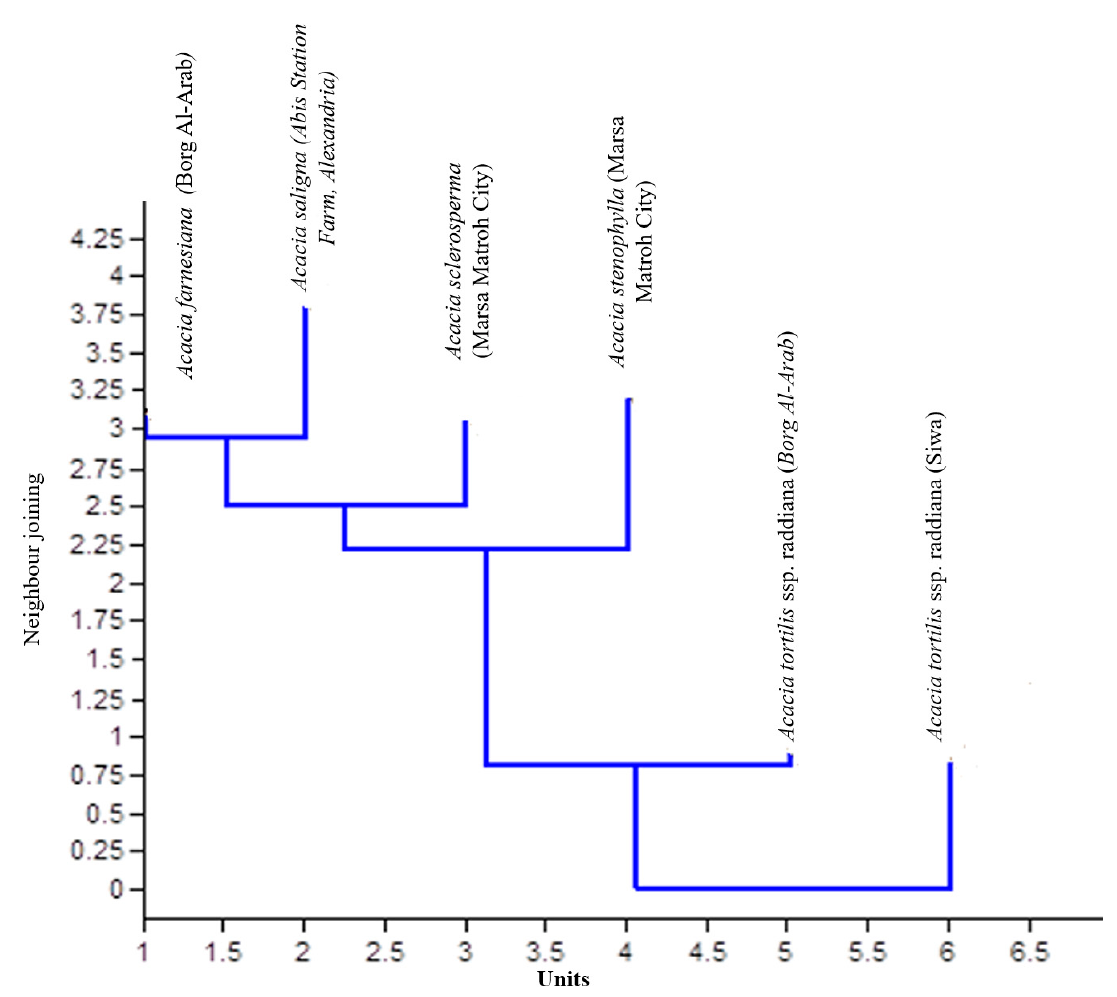
ff erent Acacia species based on forty-three RAPD Figure 6. Dendrogram of similarity of different Acacia species based on forty-three RAPD primers. Figure 6. Dendrogram of similarity of di